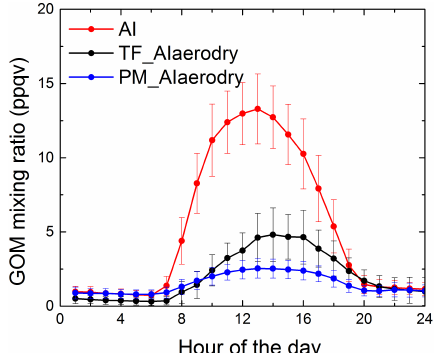
Figure 6. Simulated averaged diurnal cycles of GOM at AI (red), at TF (black) using AI dry deposition and gas–aerosol partitioning pa- rameters (“TF_AIaerodry”), and at PM (blue) using AI dry deposi- tion and gas-to-particle partitioning parameters